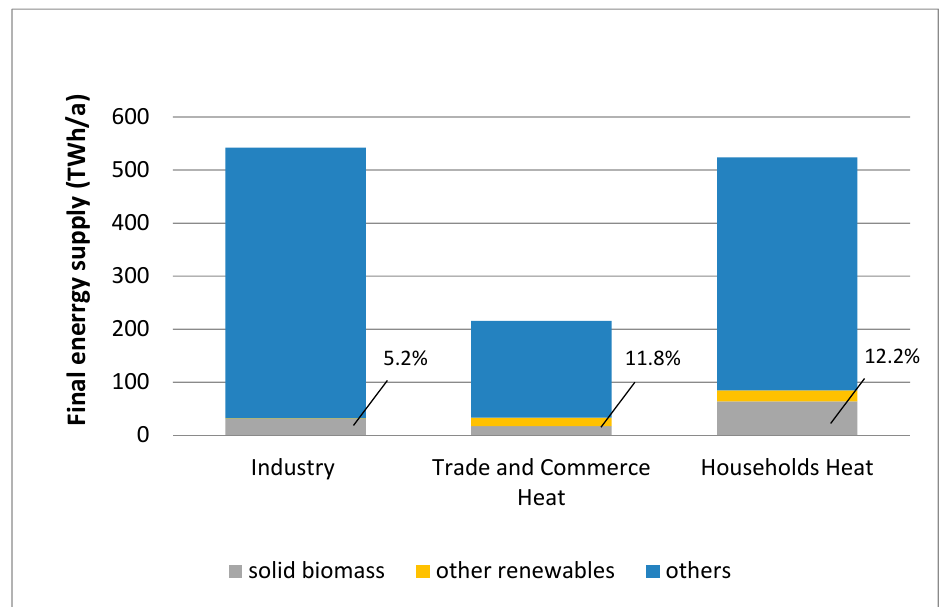
Figure 2. Contribution of different energy sources to meet sectors’ final heat demand in Germany (based on [11–13]).